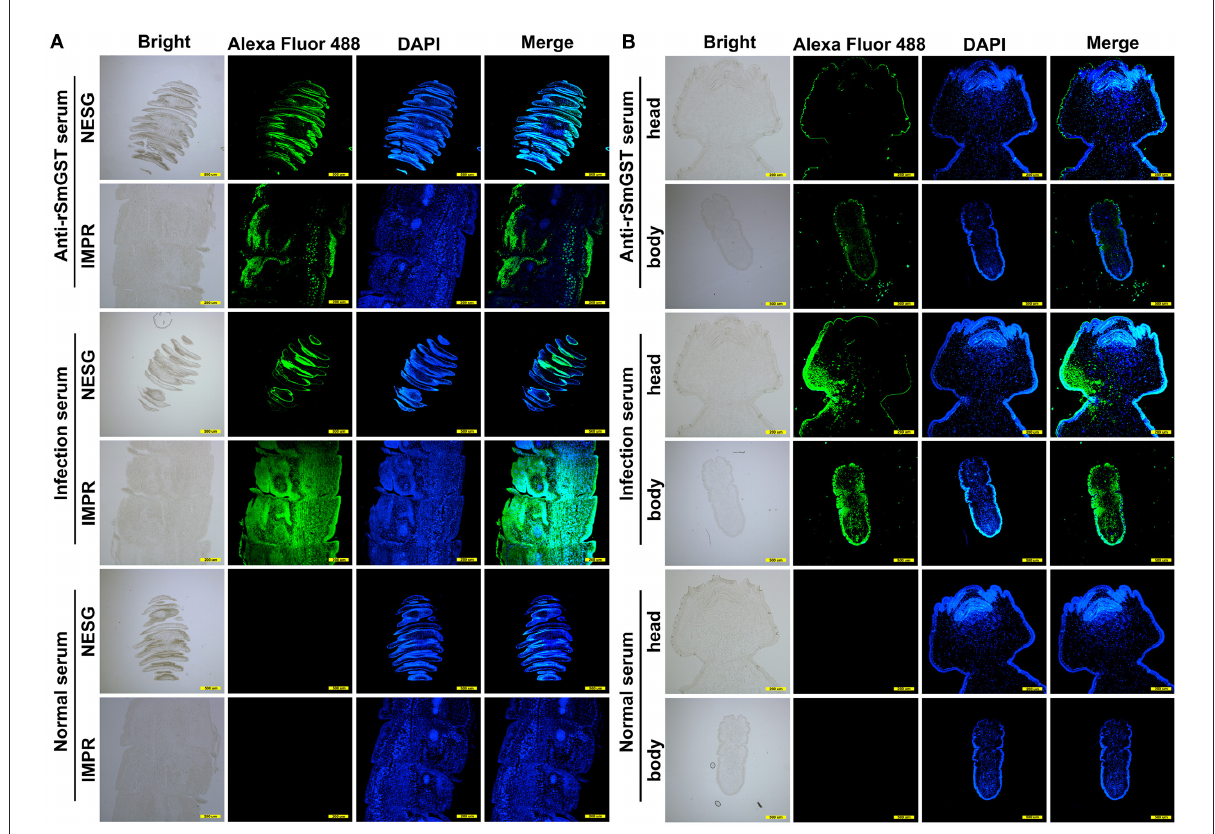
FIGURE3 Immunofluorescence localization of GST in different developmental stages of Spirometra mansoni . (A) GST location in different segments in the adult stage. IMPR indicates immature proglottide, NESG indicates neck segment. (B) GST location in the plerocercoid stage. Green fluorescence is the location of GST protein. Scale of different segments of adult: 500 µ m; Head of plerocercoid: 200 µ m; Body of plerocercoid: 500 µ m.